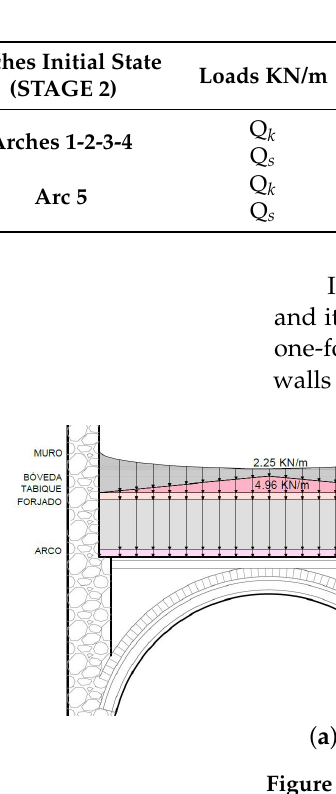
Figure 12. Final state force diagram ( a ): arcs 1, 2, 3, and 4; ( b ): arc 5. Table 3. State of loads in the final